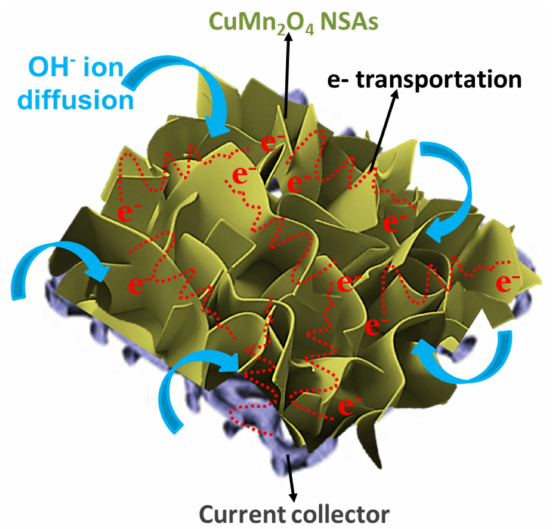
Figure 6. At different bending angles, the ( a ) CV and ( b ) GCD profiles of a CuMn 2 O 4 NSA electrode. Photographs of CuMn 2 O 4 NSA electrode bent in various angles showing the flexibility of the electrode (inset of Figure 6b).